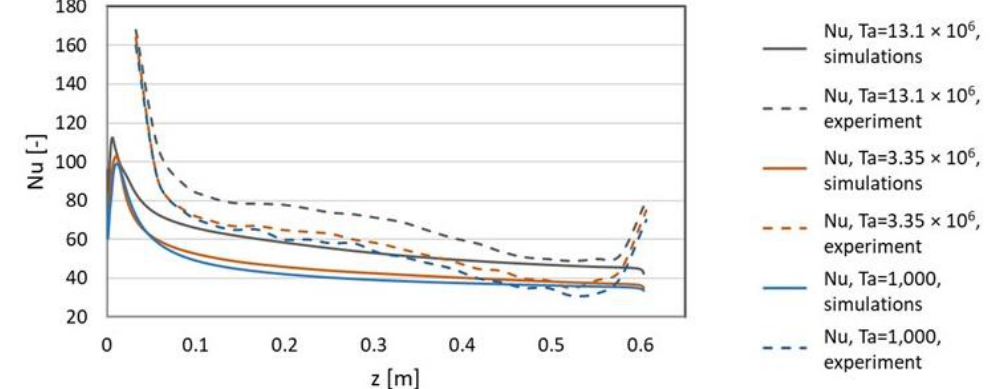
Figure 18. Simulated and experimentally obtained Nu profiles on the rotor along the length of the air gap for three different Ta values.